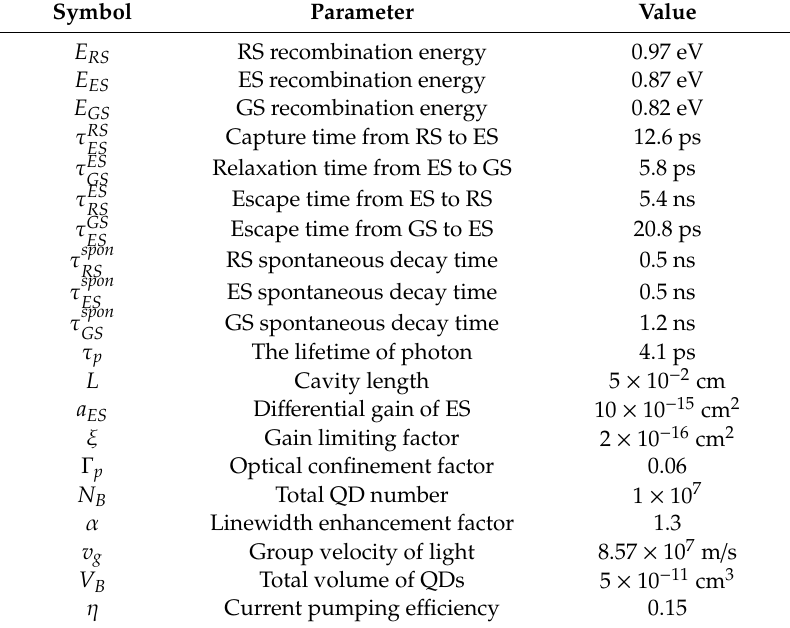
Table 1. Simulation parameters of the QD laser.